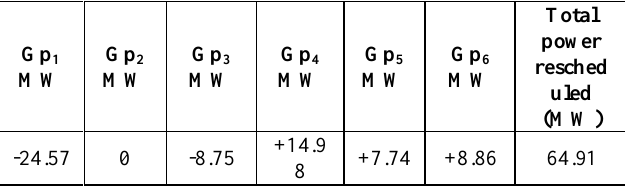
Table 12.Amount of power rescheduled (Case